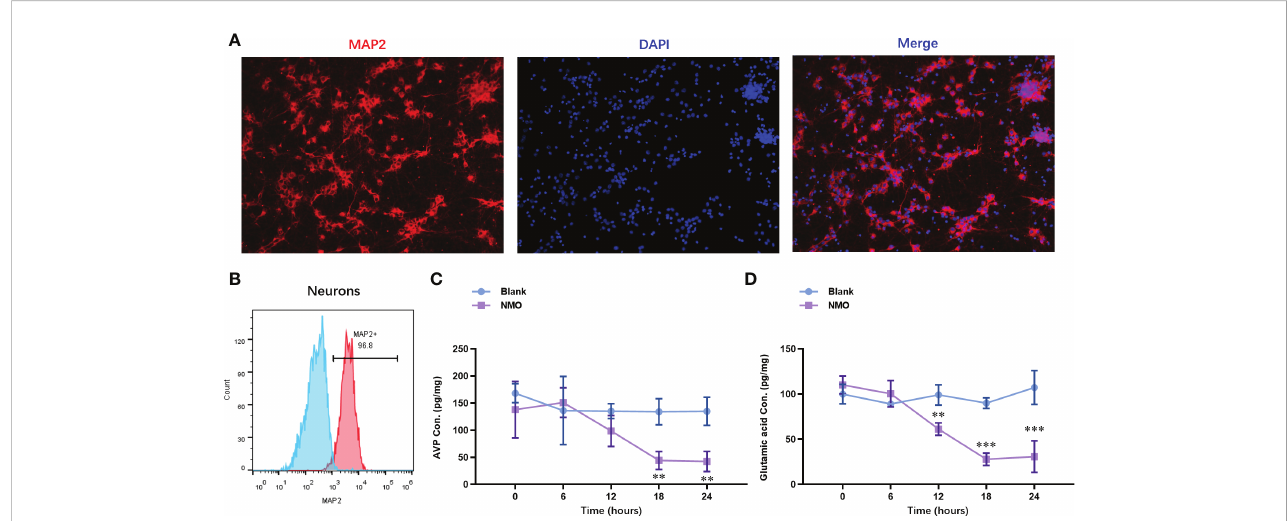
FIGURE 3 Astrocytes after NMO induction signi fi cantly decreased the neuropeptides (AVP and VIP) released from co-cultured neurons. (A) The identity of neurons was con fi rmed with the expression of MAP2 by immuno fl uorescence staining. (B) The purity of neurons was further con fi rmed by fl uorescence activated cell sorting (FACS) analysis, which was up to 96.8%. After the co-culture of NMO inducted astrocytes and neurons for 0,6,12,18 and 24 hours. The protein level of AVP (C) and VIP (D) were detected by ELISA kits. ** P <0.01, *** P <0.001, compared with the blank group. N=3.